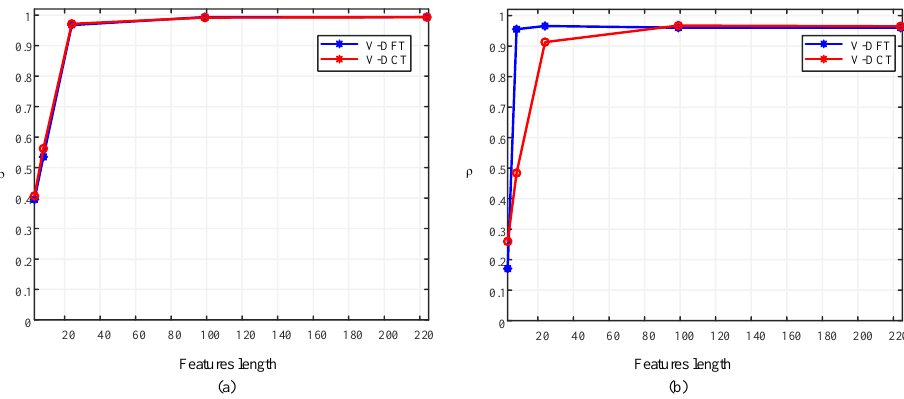
Figure 11. Examples of monitoring results as a function of IQH-DFT and IQH-DCT features lengths: ( a ) OSNR monitoring at η = 1.1 and CD = 0 ps/nm; ( b ) CD monitoring at η = 1.1 and OSNR = 24 dB.